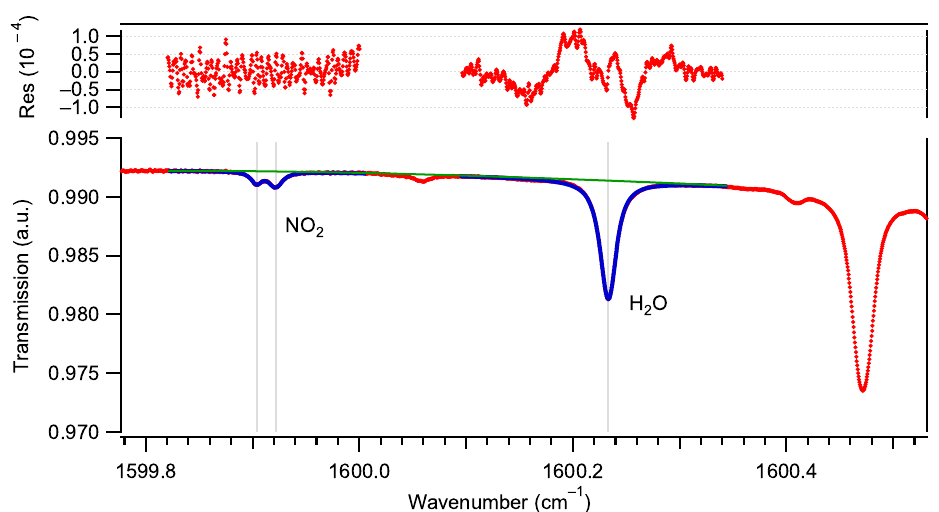
Figure 2. Measured transmission spectrum (red dots, averaged over 10 4 spectral scans, corresponding to 1s acquisition time) of an ambient air sample containing 10ppbv of NO 2 and 0.1% (absolute) of H 2 O, along with the associated Voigt profile (blue line) and baseline fit (green line). The fit residual is shown on the top